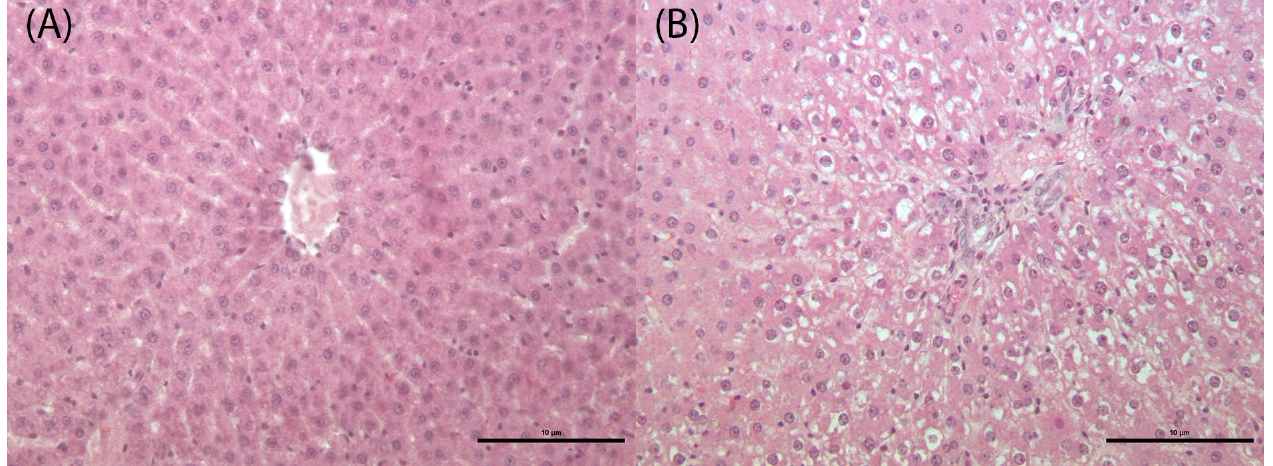
Figure 7. Liver of male rats subcutaneously treated five times a week, for 2 weeks with 0—sesame oil Panel ( A ) and 0.09 + 0.93 mg of estradiol valerate plus cyproterone acetate panel ( B ). Hepatocyte vacuolation. Bar 10 m (original magnification 20×; haematoxylin and eosin stain).